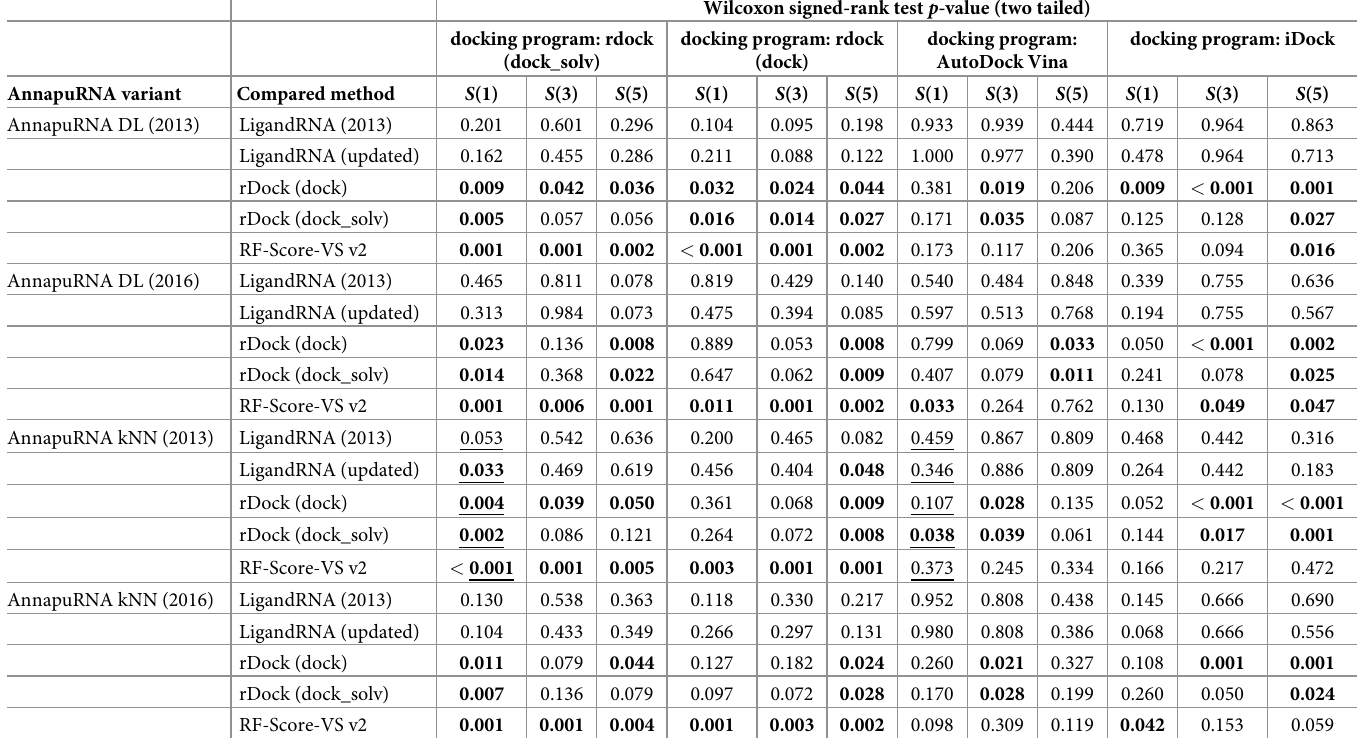
Table 3. P -values obtained in a Wilcoxon signed-rank test comparing the distribution of S (1), S (3), and S (5) values of AnnapuRNA and other docking programs. Docking was performed using native conformation of a ligand as an input. Two-tailed p -values � 0.05 are in bold. Data referenced in the main text are